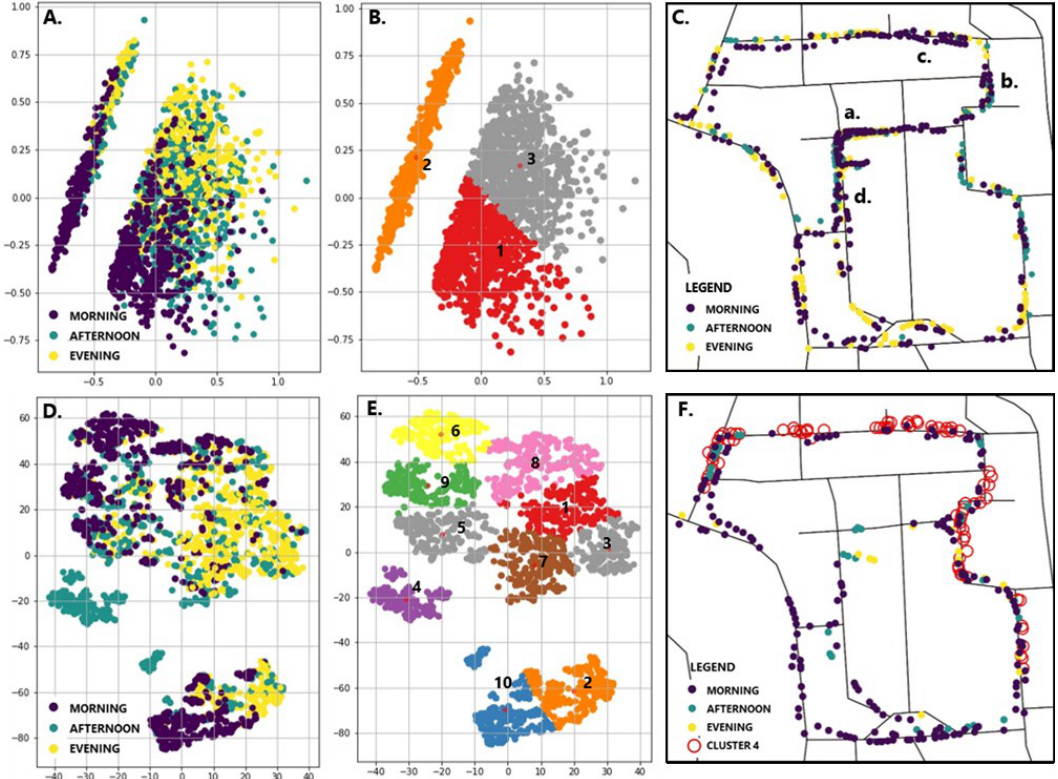
Figure 8. Identifying patterns in the dataset with Principal Component Analysis (PCA) and t-distributed stochastic neighbor embedding (t-SNE) clustering.